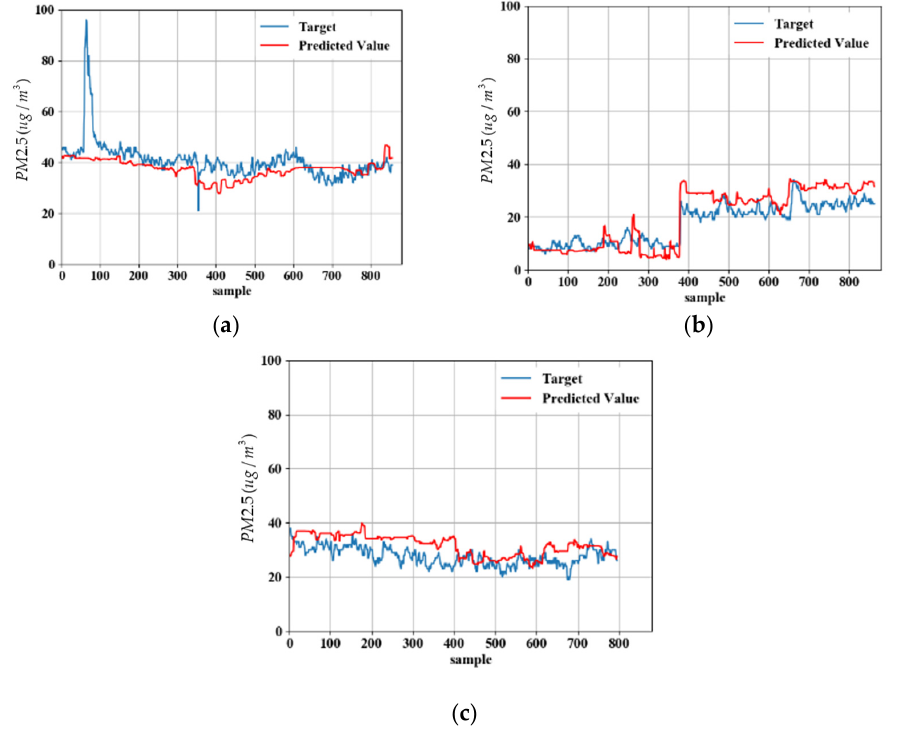
Figure 19. Prediction results of the random forest model: model prediction results for ( a ) 15 February, ( b ) 28 February, and ( c ) 1 March 2019.